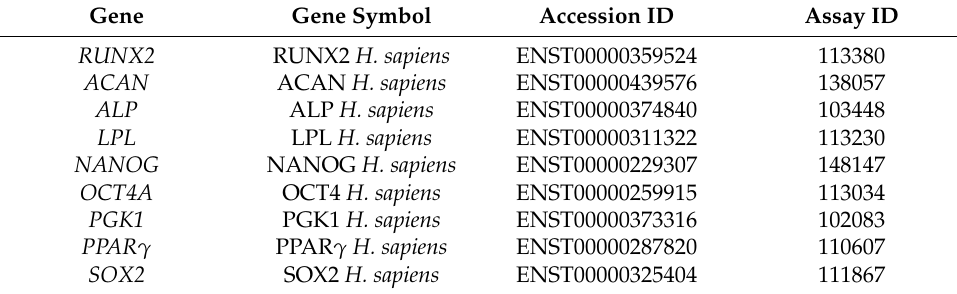
Table 2. Real-time PCR primers (Roche, Indianapolis, IN,